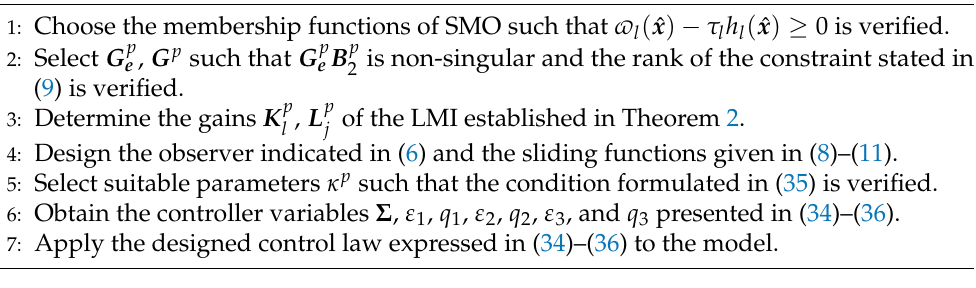
Algorithm 1 Procedure design